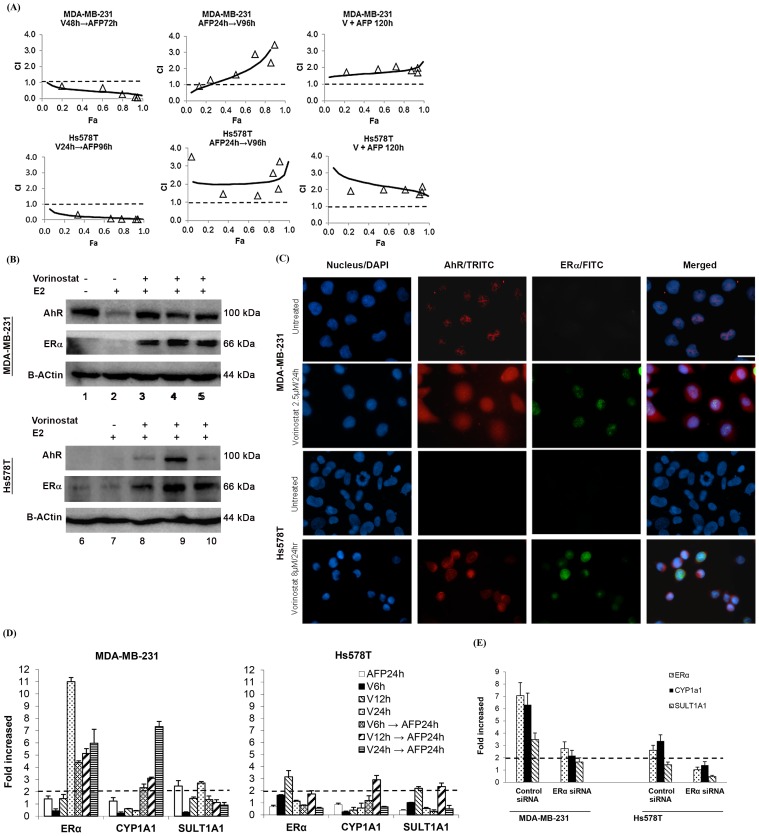
Vorinostat sensitized mesenchymal-like TNBC MDA-MB-231 and Hs578T cells to AFP464 by, at least in part, reactivating ERα expression and restoring AhR responsiveness to AF, as indicated by transcriptional induction of CYP1A1.(A) Fraction-affected (Fa) versus combination index (CI) plots of sequential or simultaneous treatment with vorinostat (V) and AFP464 (AFP) in MDA-MB-231 and Hs578T cells. AFP464 and vorinostat were combined at a fixed concentration ratio of 5∶1 for both cell lines. The open triangles represent experimental CI values, and the solid lines represent simulated CI values, both of which were calculated by Calcusyn software based on the mean cell proliferation data from two independent experiments. CI >1.0, CI = 1.0, and CI <1.0 indicates antagonistic, additive, and synergistic effects, respectively. (B) Western blot of ERα and AhR in control and vorinostat-treated MDA-MB-231 and Hs578T cells. Cells were grown in phenol red-free medium supplemented with charcoal-stripped FBS for 1 week prior to the treatment. MDA-MB-231 and Hs578T cells were treated with vorinostat at their respective IC50 values (2.5 and 8 µM) for 6, 12, or 24 h (Lanes 3, 4, and 5, respectively) followed by incubation in fresh medium containing E2 (100 nM) for an additional 24 h. (C) Immunofluorescence staining of ERα and AhR in control and vorinostat-treated MDA-MB-231 and Hs578T cells. The cells were treated in the same way as for western blot analysis. The blue DAPI, red TRITC, and green FITC staining indicates positive staining for the nucleus, AhR, and ERα, respectively. (D) Real-time RT-PCR determination of relative mRNA levels of ERα, CYP1A1, and SULT1A1 in MDA-MB-231 and Hs578T cells treated with vorinostat (V) and AFP464 (AFP) at their respective IC50 values, each alone or in sequential combination. (E) Real-time RT-PCR demonstrated that transient knockdown of ERα in the vorinostat-pretreated MDA-MB-231 and Hs578T cells diminished AhR-dependent transcriptional induction of CYP1A1 and SULT1A1 after AFP464 treatment. MDA-MB-231 and Hs578T cells were pretreated with vorinostat at their respective IC50 values (2.5 or 8 µM) for 24 and 12 h, respectively, and then the cells were incubated with the ERα siRNA:transfection reagent (1∶8) mixture complexes in fresh drug-free medium for 4 h. After that, the cells were re-covered in fresh complete medium for 2 h and then treated with AFP464 at their respective IC50 values (25 or 20 µM) for 24 h.